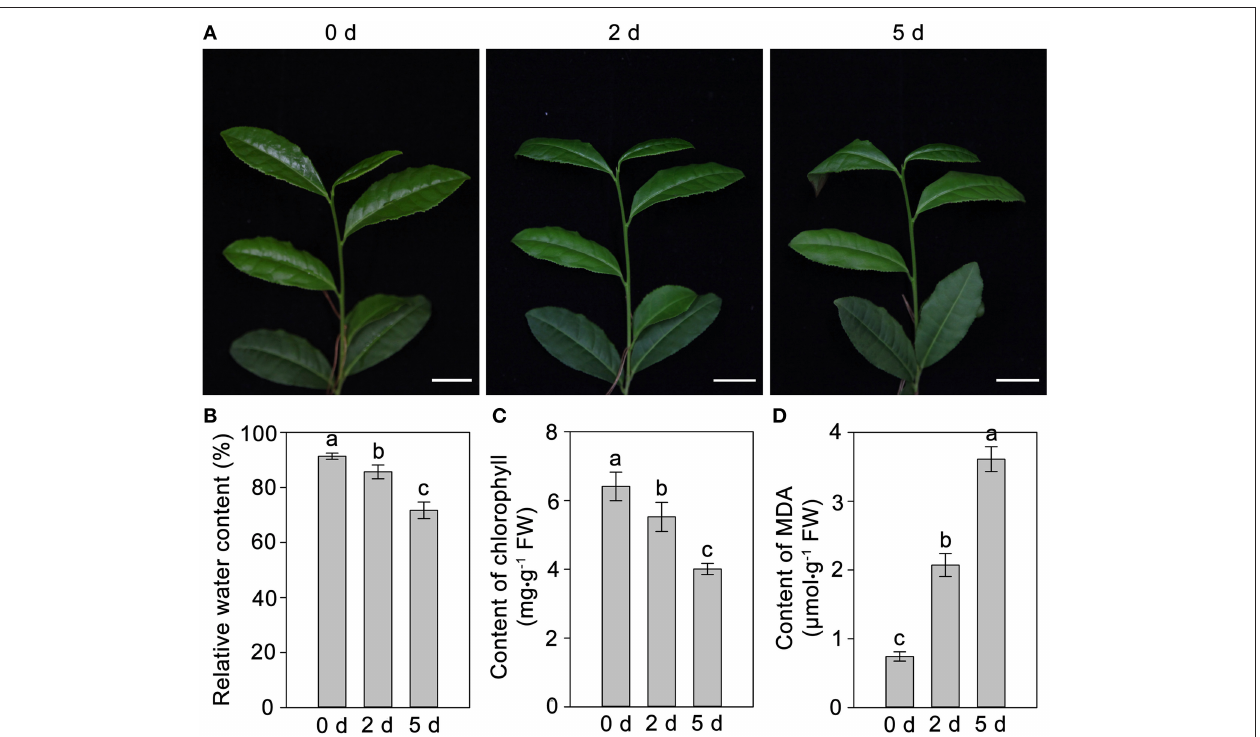
FIGURE 1 | Effects of drought stress on the phenotype and physiological characteristics of C. sinensis leaves. The leaves begun to wilt at 2 days under drought stress, the wilting degree of leaves deepened and exhibited scorch in leaf tips at 5 days (A) . The RWC and chlorophyll content in C. sinensis leaves decreased rapidly (B,C) and the content of MDA increased significantly (D) at 2 and 5 days after treated with drought